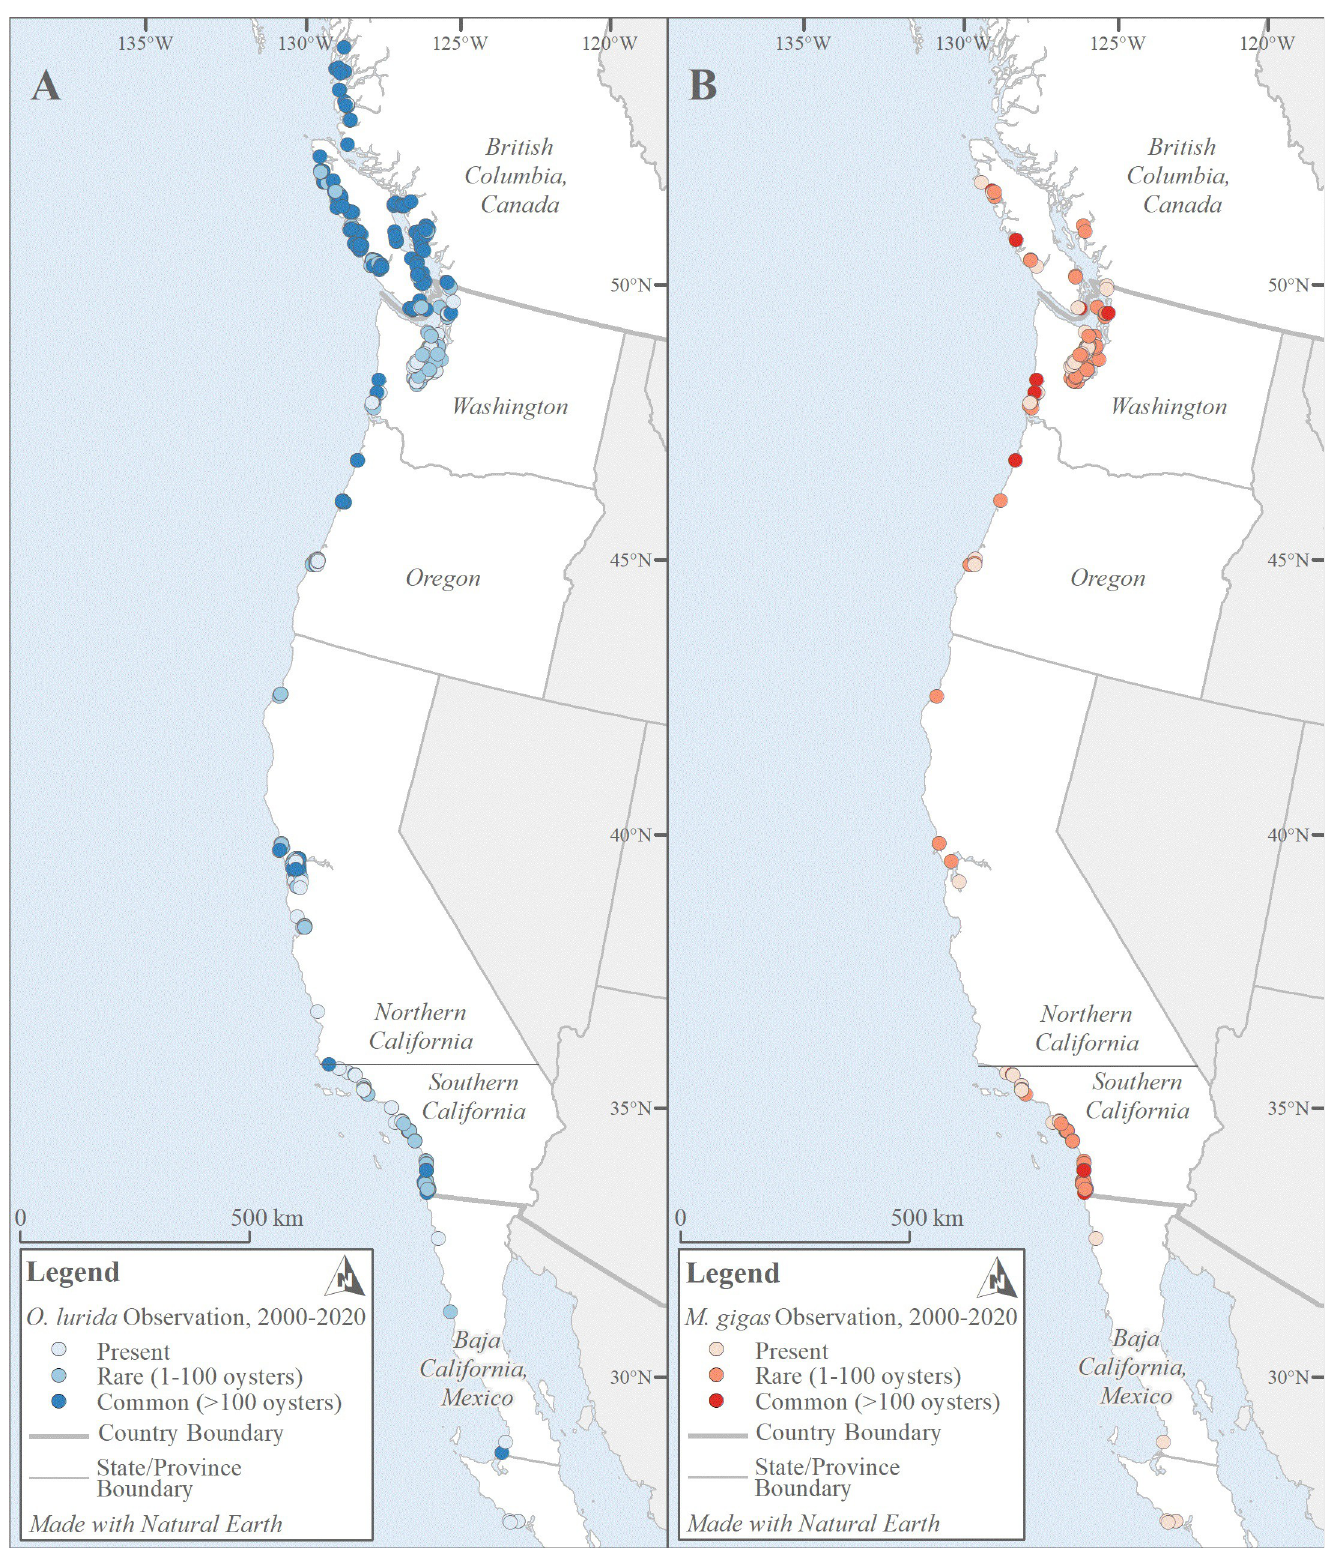
Fig 11. Coast-wide oyster abundance. The abundances of O . lurida (A) and M . gigas (B) vary by region. Note that some points may not be visible ( i . e ., they are hidden beneath other points) due to map scale. https://doi.org/10.1371/journal.pone.0263998.g011 PLOS ONE | https://doi.org/10.1371/journal.pone.0263998 March 17,